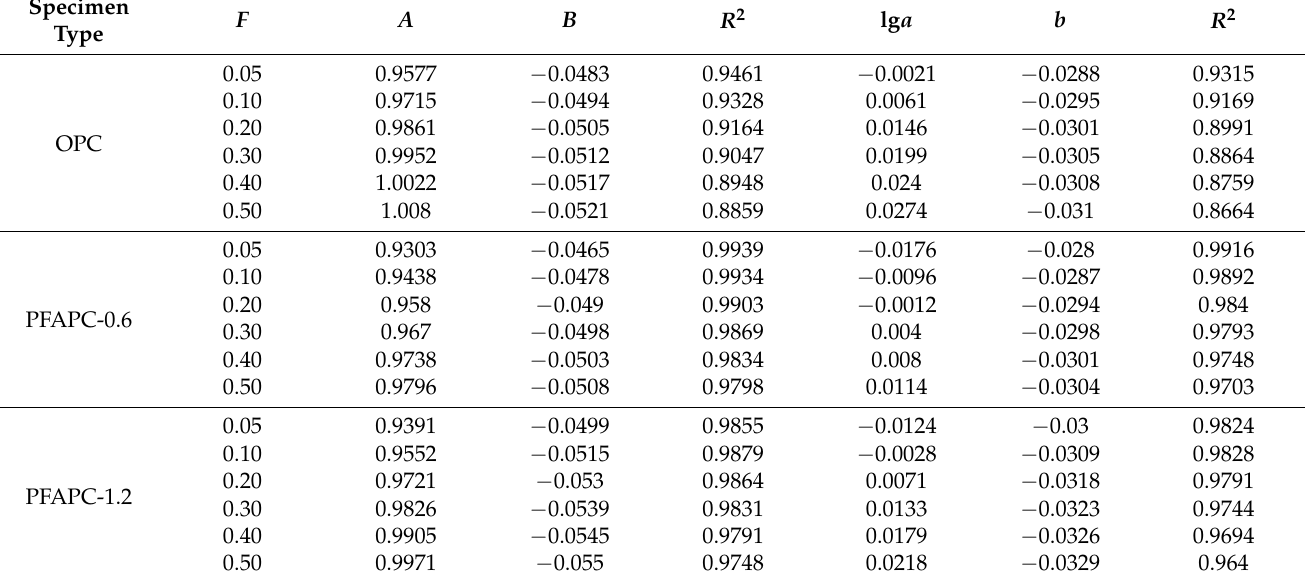
Table 9. Regression coefficients considering failure